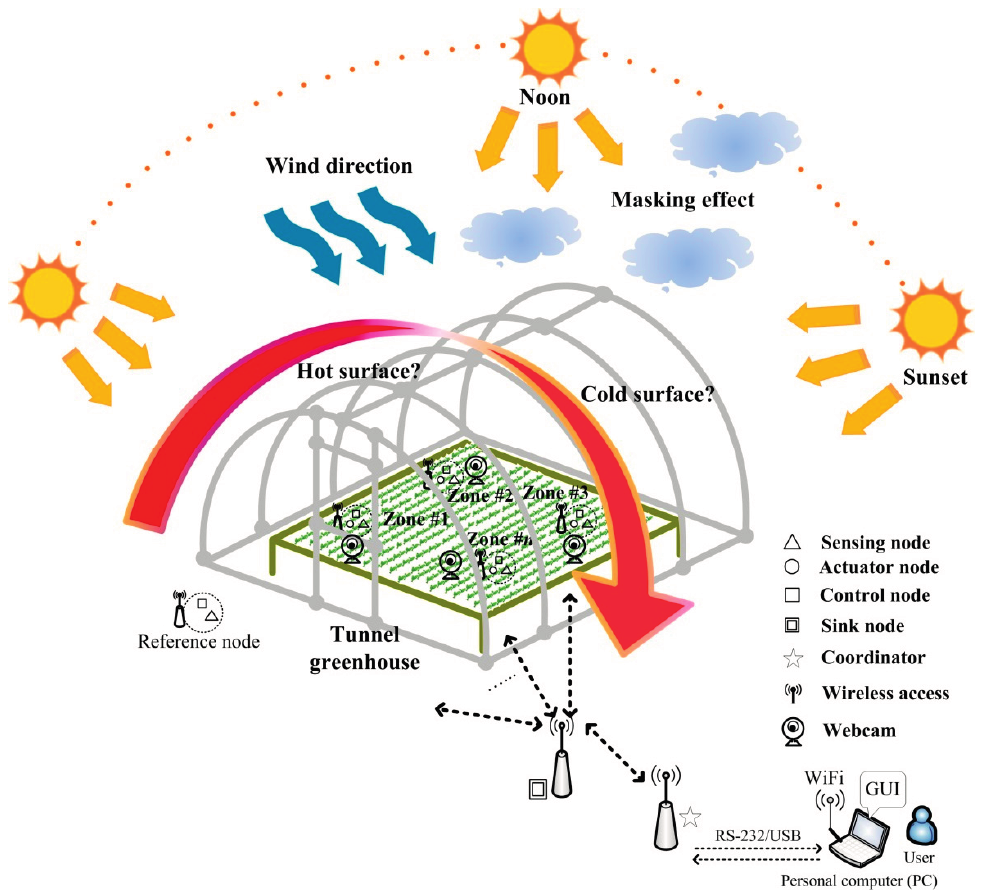
Figure 1. The proposed system architecture is under unpredictable environmental